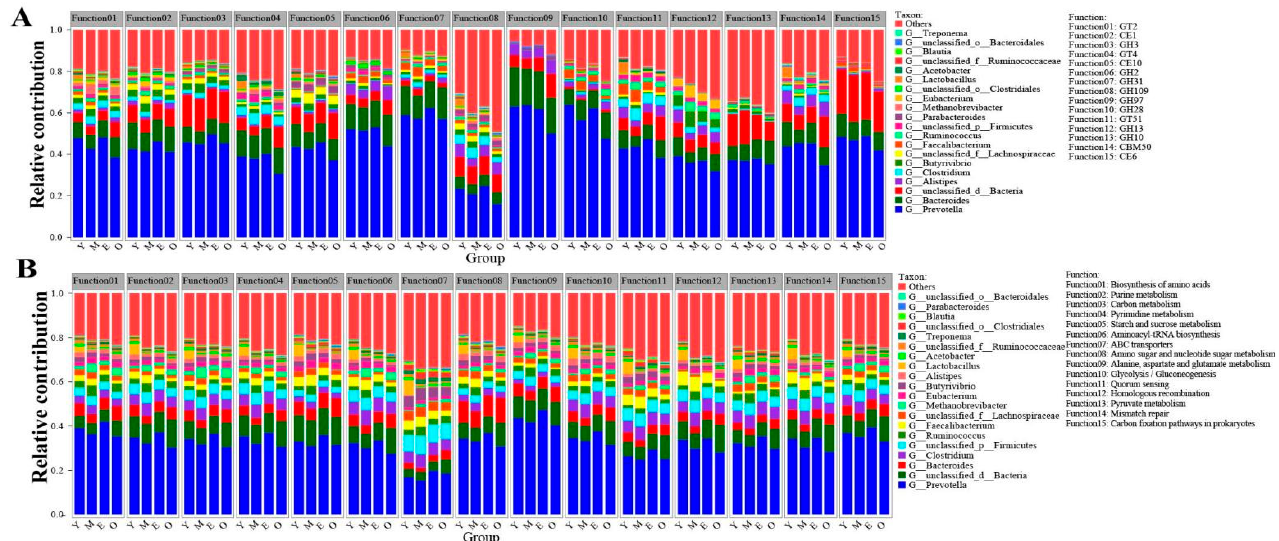
Figure 4. Relative contribution of different taxa (genus levels) to identified rumen-enriched functional attributes of CAZymes encoded genes at the family level ( A ) and KEGG pathway level 3 ( B ) in different samples. GH: glycoside hydrolases; GT: glycosyltransferase; CE: carbohydrate esterases; CBM: carbohydrate-binding modules.